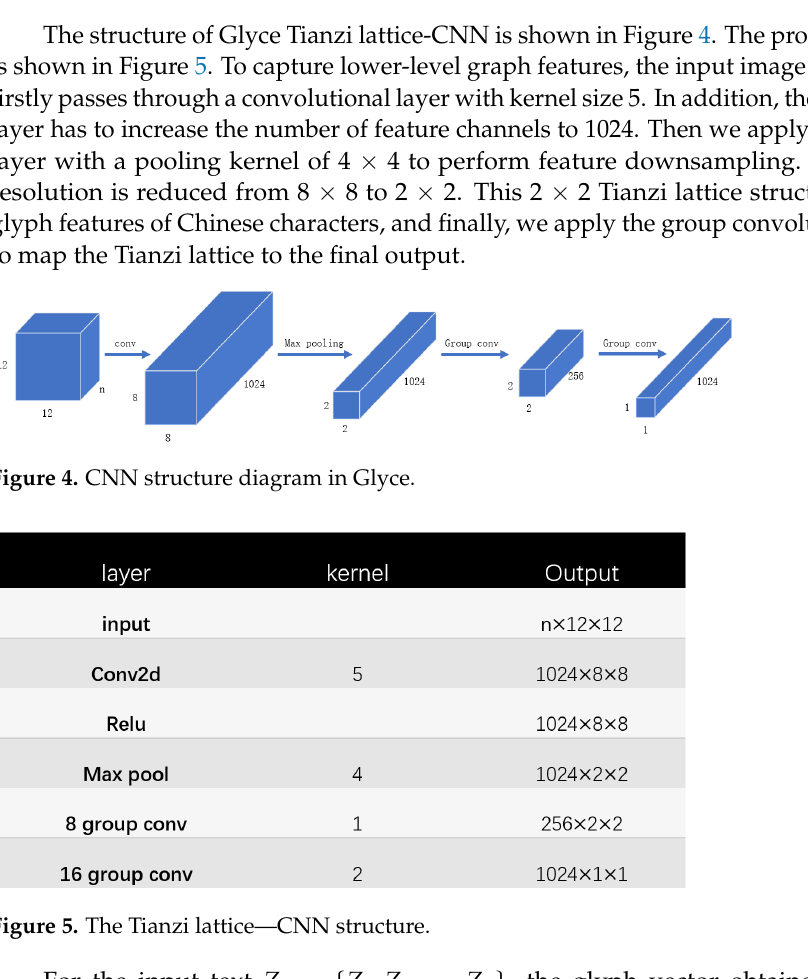
Figure 5. The Tianzi lattice—CNN structure.